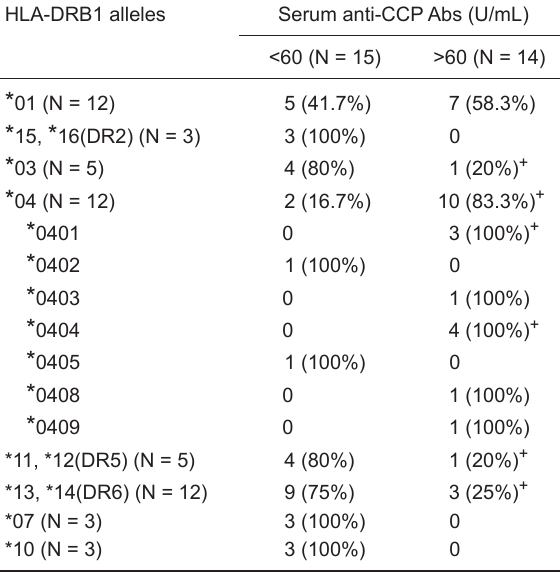
Table 3. HLA-DRB1 allele distribution among rheumatoid arthritis patients with serum anti-CCP antibody titers <60 U/mL and >60 U/mL.